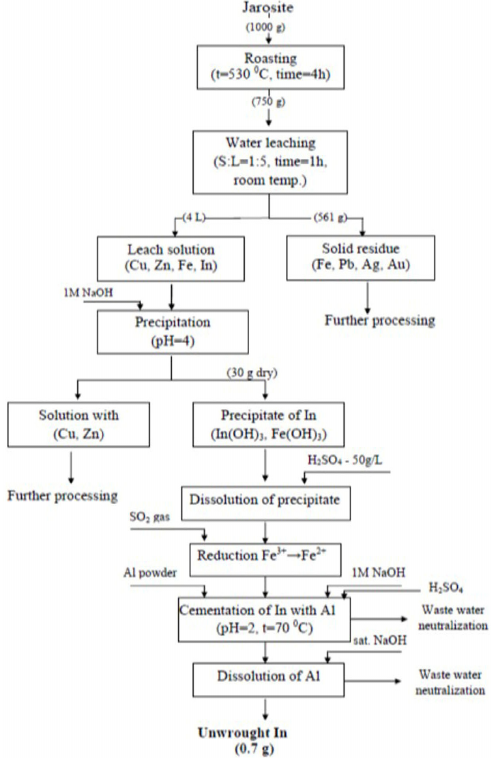
Figure 9. Methodological approach for processing jarosite tailings waste.